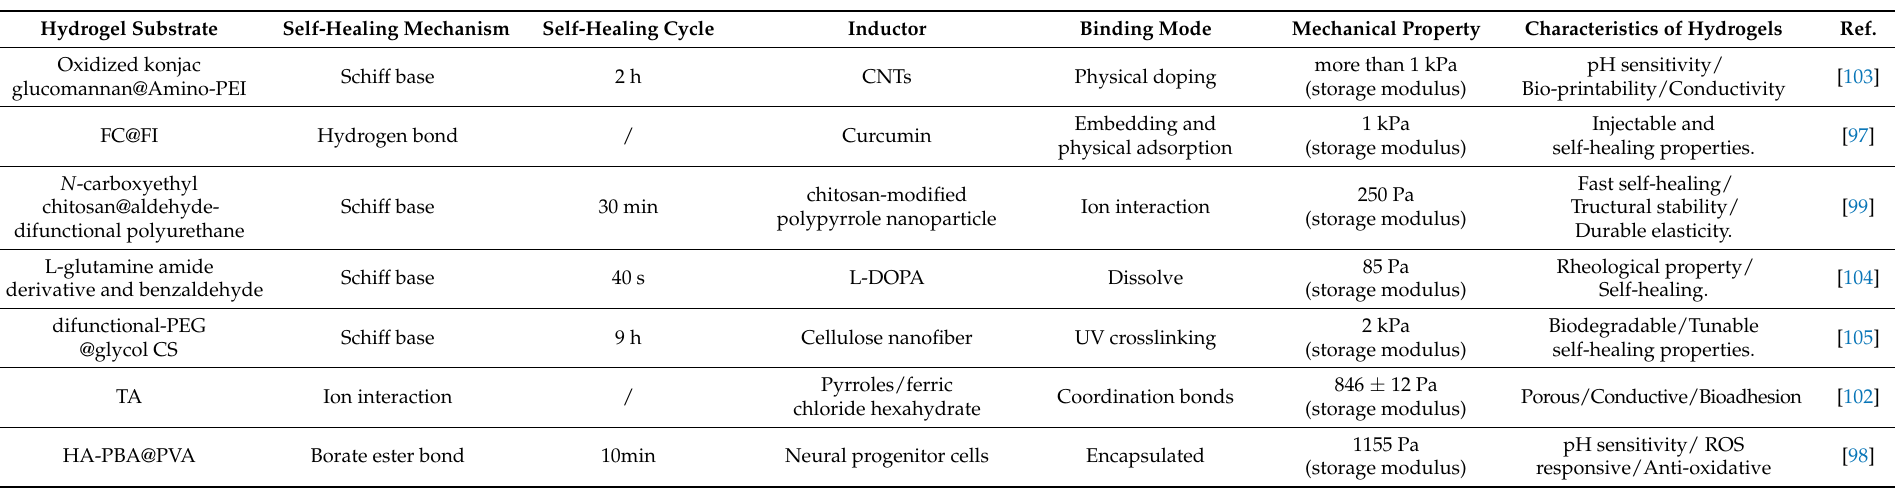
Table 5. Self-healing hydrogel for nerve injury